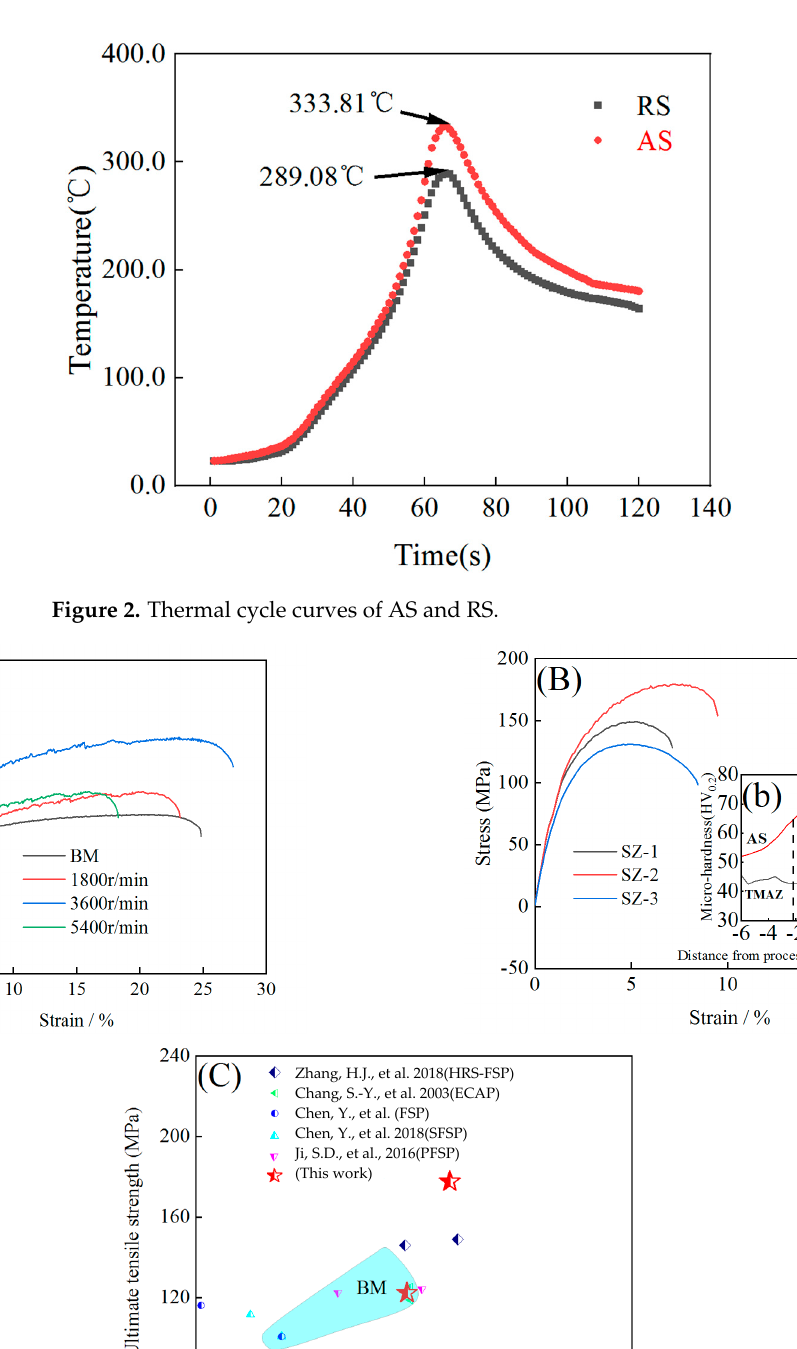
Figure 2. Thermal cycle curves of AS and RS.